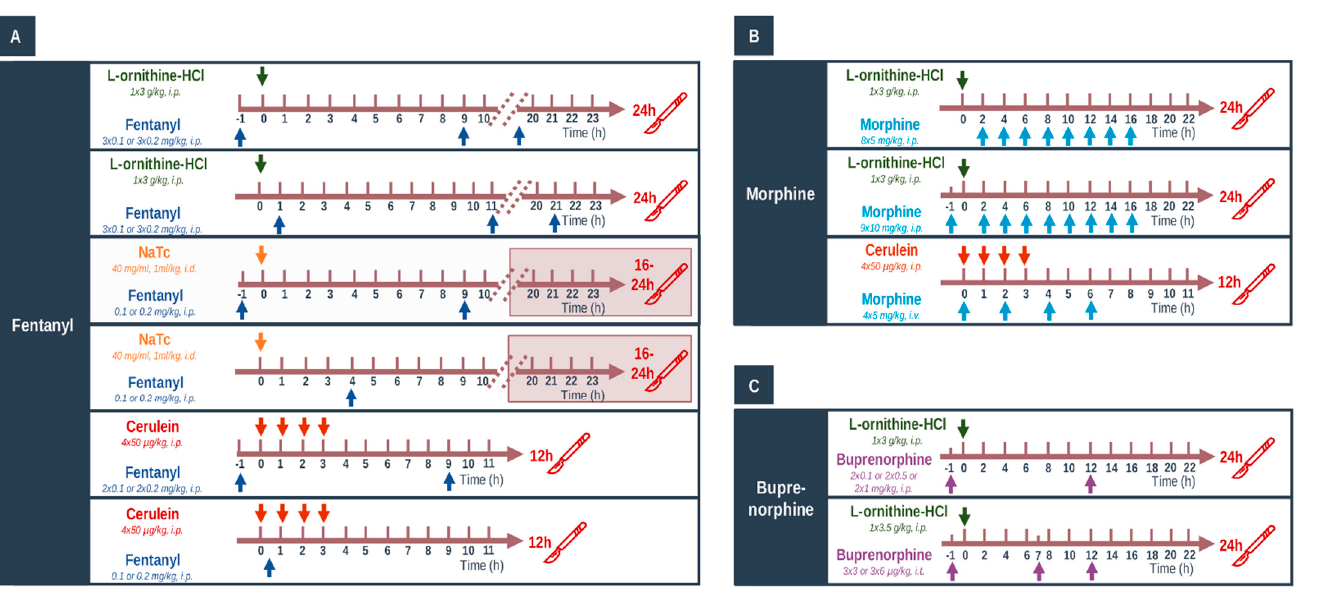
Figure 12. ( A – C ) Schematic view of experimental setup. Treatment arrangements for acute pancreatitis (AP) induction and opioid administration in Wistar rats. Arrows above or below the timeline show the injections. Control animals were injected with physiological saline. Abbreviations: